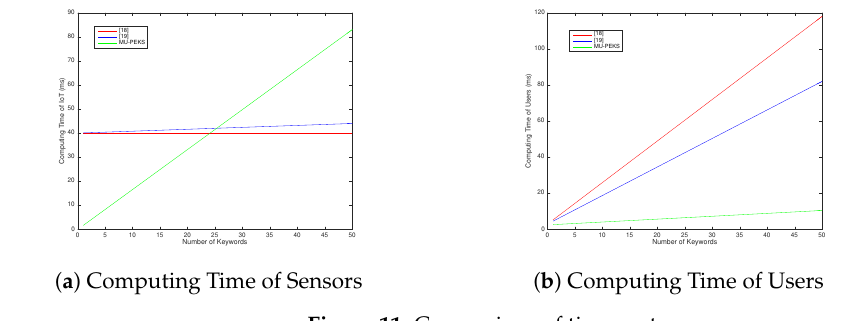
Figure 11. Comparison of time